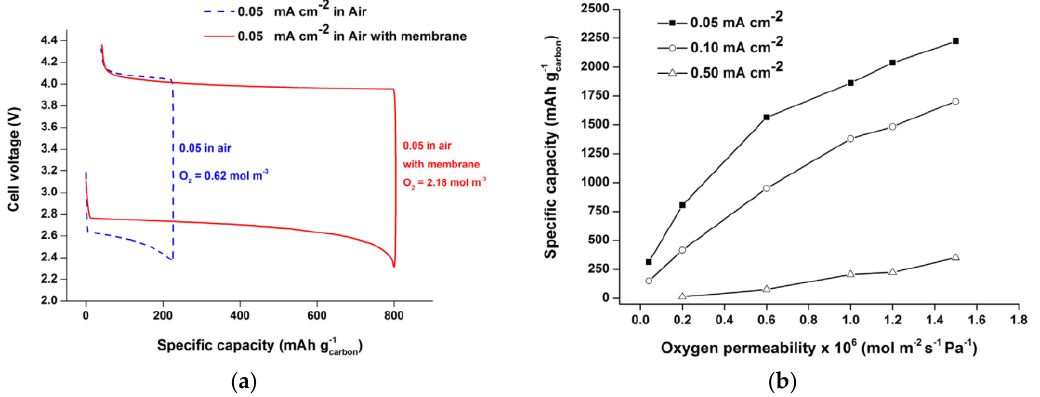
Figure 29. ( a ) Comparison of voltage–capacity curves for a nonaqueous Li-air battery operated in ambient air with and without an oxygen-selective membrane at a rate of 0.05 mA/cm 2 ( b ) Effect of oxygen permeability on maximum specific discharge capacity at different discharge rates for a nonaqueous Li-air battery protected with a 50-mm-thick oxygen-selective membrane. Reprinted from Sahapatsombut et al. [38], with permission from Elsevier.